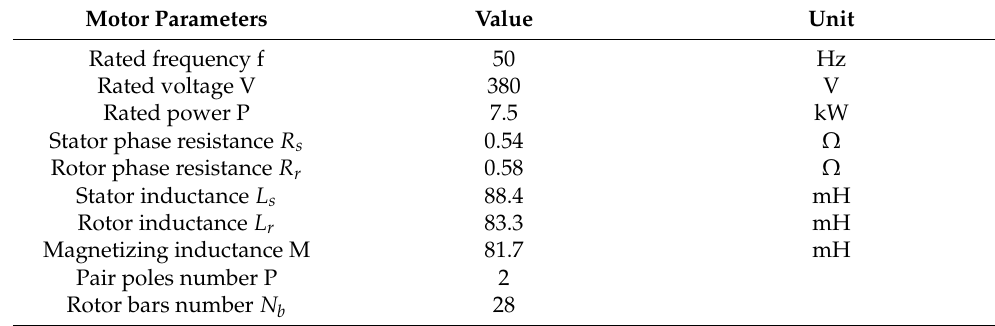
Table 5. Induction motor parameters.